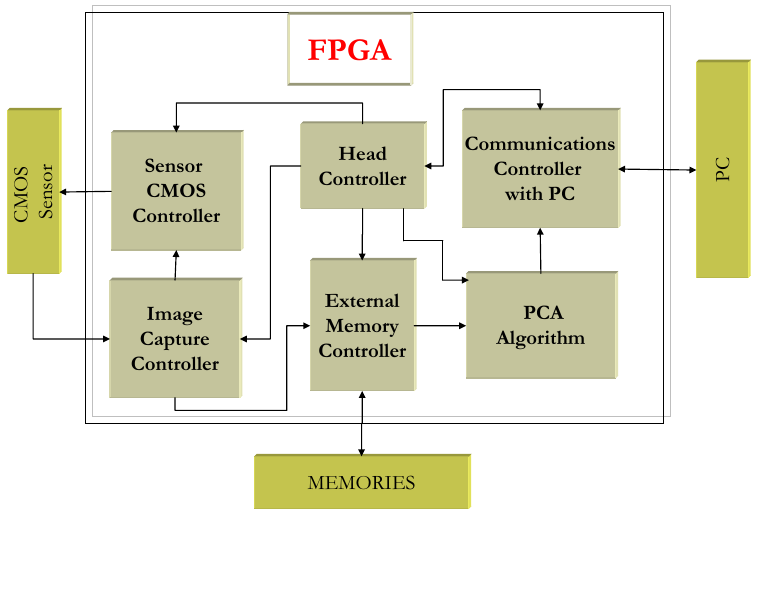
Figure 1. Block diagram of the internal architecture of the